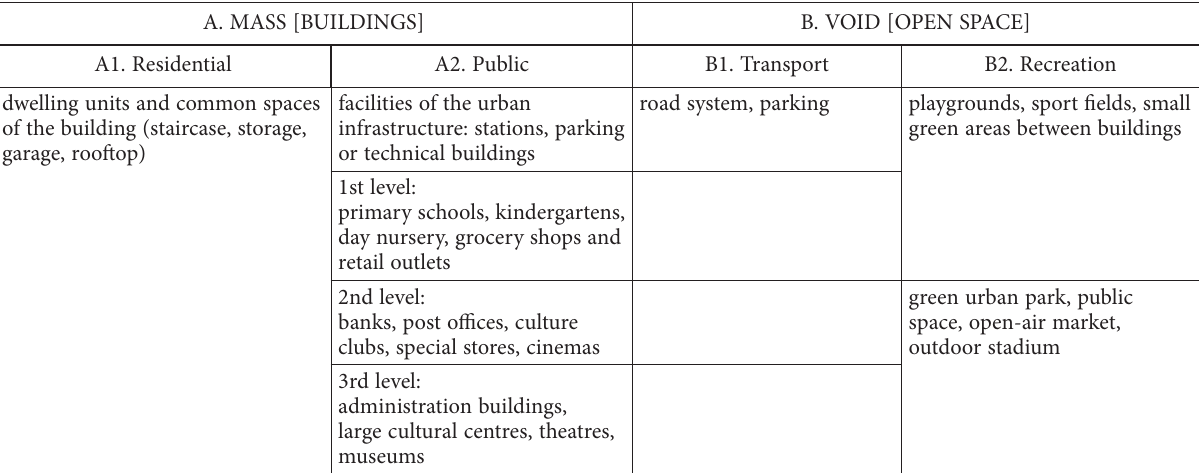
Table 1. Typology of functions in LHEs (source: author,